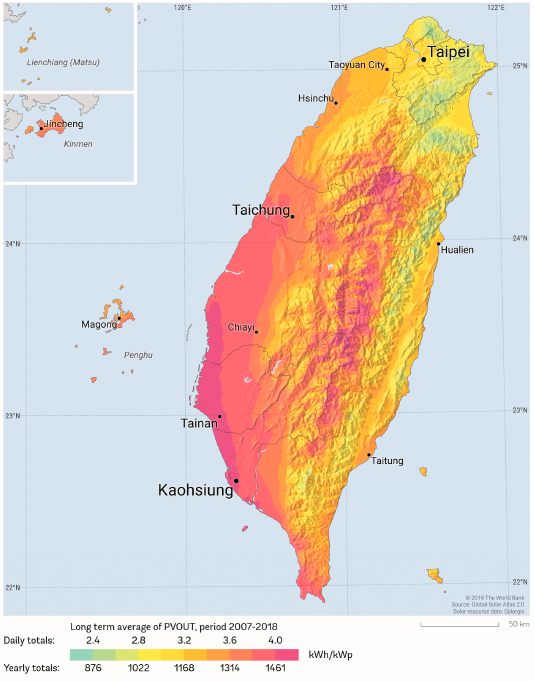
Figure 2. Photovoltaic power potential across Taiwan (© 2020 The World Bank, Source: Global Solar Atlas 2.0, Solar resource data: Solargis).